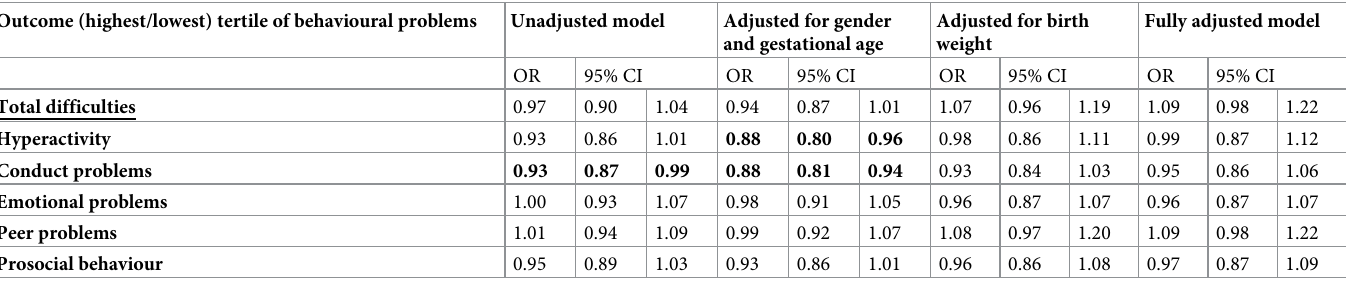
Table 5. Weighted models for association of birth length and childhood behavioural problems measured using strength and dificulties questionnaires at age 7 in the Czech ELSPAC cohort. Outcome (highest/lowest) tertile of behavioural